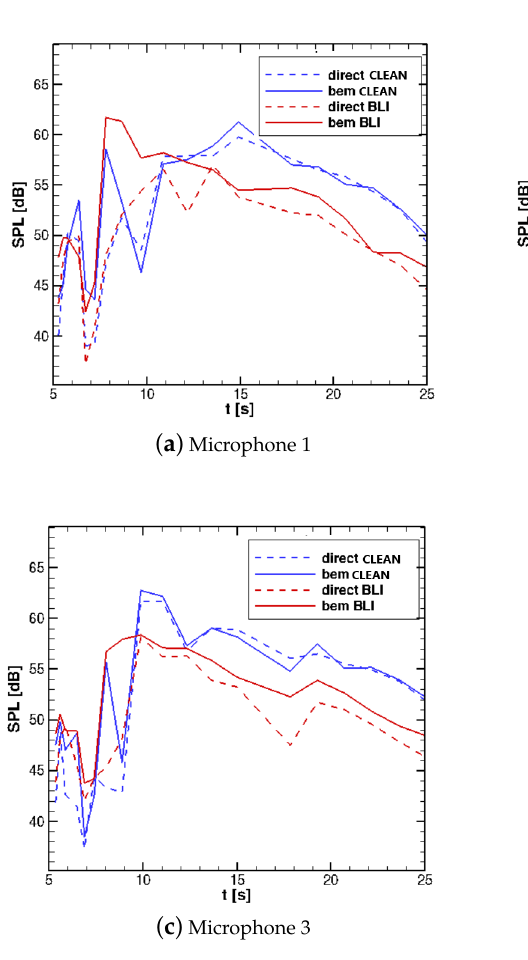
Figure 19. SPL time history on three locations on the